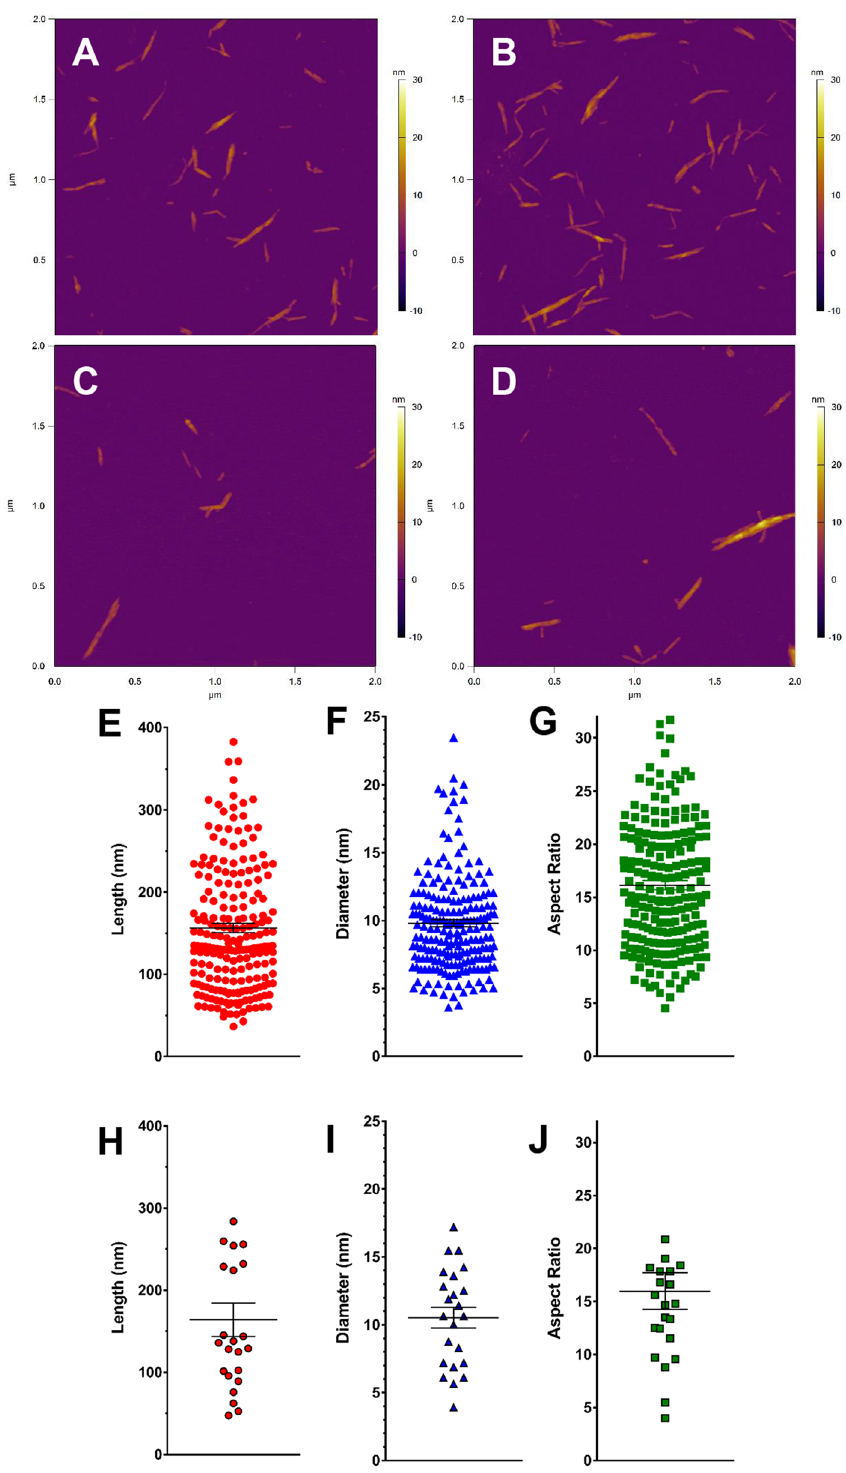
Figure 3. Representative AFM images of pristine CNC ( A,B ) and fCNC ( C,D ) on a mica substrate show linear shaped molecules in both the starting material and the product populations. The characteristic high aspect ratio and rigid linear shape of the starting material is preserved following the functionalization procedures and confirms the TEM results. Analysis of pristine CNC particle length ( E ), diameter ( F ), and aspect ratio ( G ) shows a length of 156.6 ± 5.70 nm, diameter of 9.81 ± 0.27 nm, and aspect ratio of 16.14 ± 0.43 (mean ± SEM, n = 214). Analysis of fCNC particle length ( H ), diameter ( I ), and aspect ratio ( J ) shows a length of 164.0 ± 20.3 nm, diameter of 10.52 ± 0.76 nm, and aspect ratio of 15.97 ± 1.73 (mean ± SEM, n =